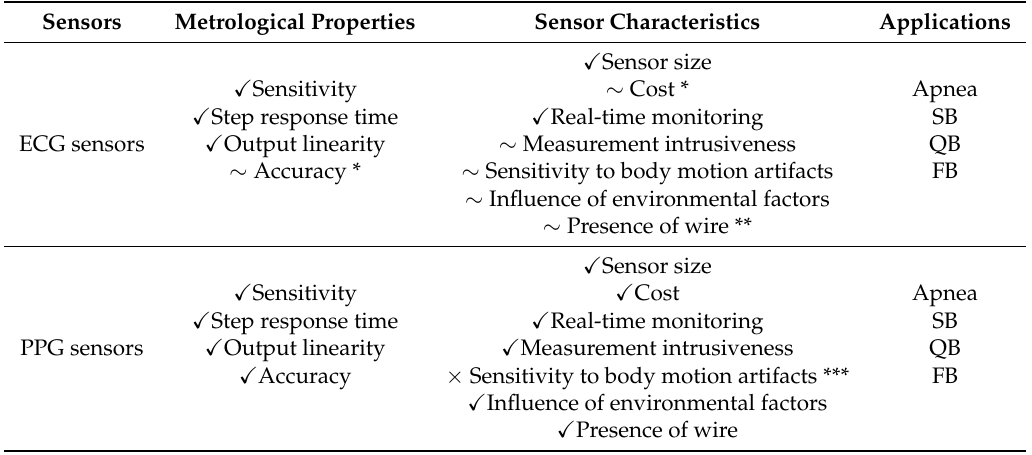
Table 9. Main metrological properties and characteristics of the biopotential and light intensity sensors used for f R measurement. (cid:88) good to excellent, ∼ sufficient, ×